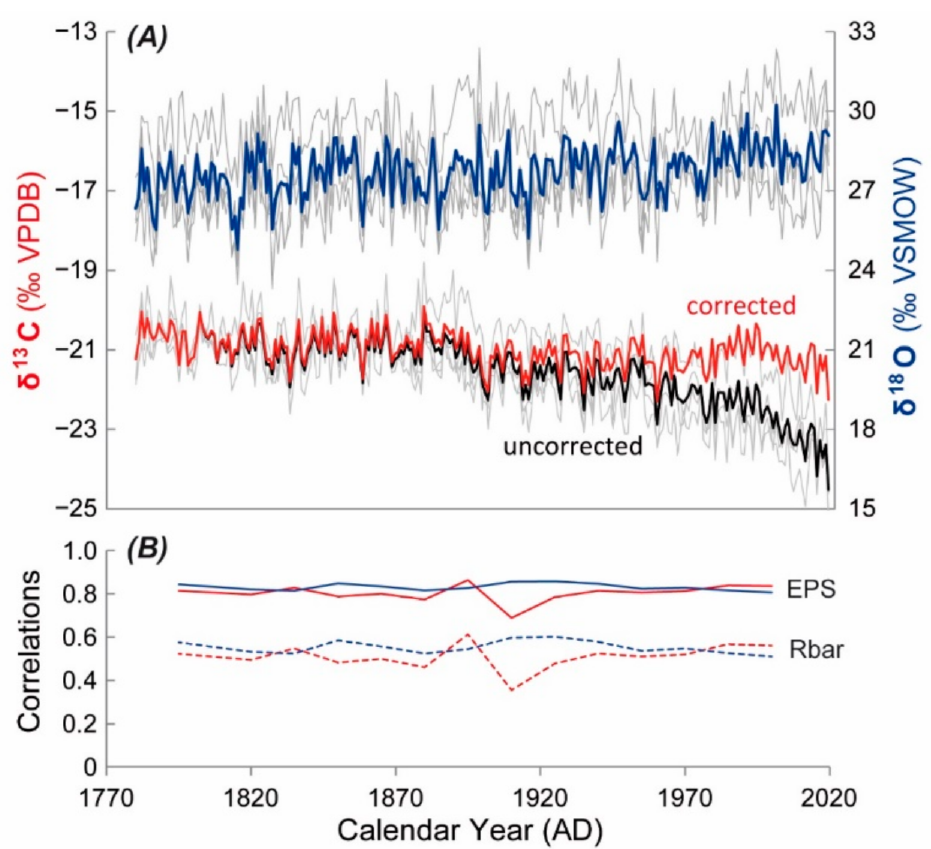
Figure 3. ( A ) Raw (grey lines) and averaged time series (1780–2018) of stable carbon ( δ 13 C) and oxygen ( δ 18 O) isotopic ratios in tree rings. Time series of δ 13 C data are presented as both uncorrected (black line) and corrected for an anthropogenic increase in CO 2 concentration in the atmosphere (red line). ( B ) Expressed population signal (EPS; solid lines) and inter-series correlation (Rbar; dashed lines) of the raw δ 13 C and δ 18 O series are shown. EPS and Rbar statistics were calculated over 30-year windows lagged by 25 years. The average values of Rbar and EPS for both isotopes are >0.5 and >0.8,